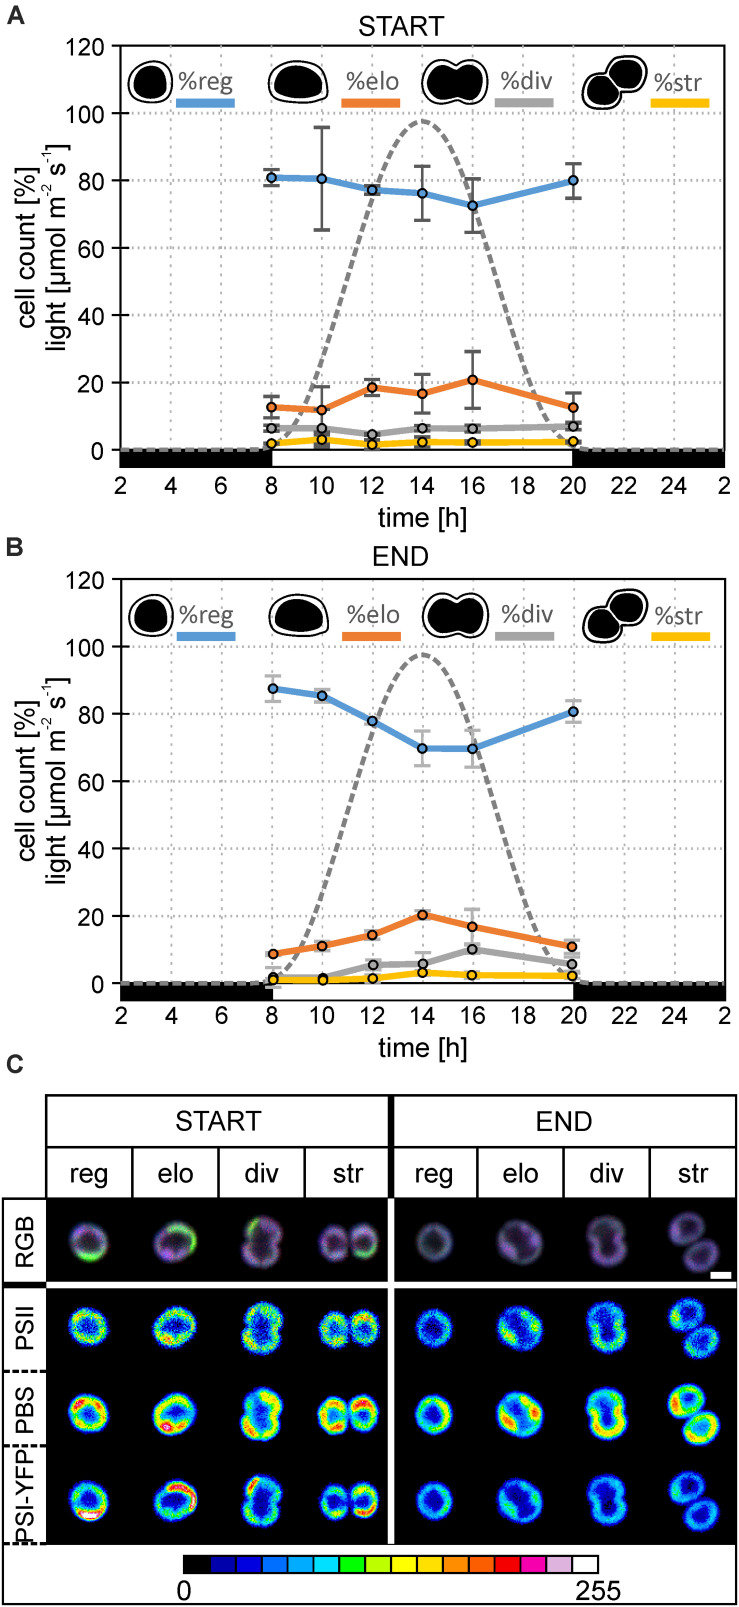
Changes in the diel distribution of cell types and microdomain localization in the particular type of Synechocystis PSI-YFP cells. The original starting culture (“START”; cells acclimated to continuous light; days 2 and 3 in the bioreactor) was slowly acclimated in the bioreactor to the sinusoidal light- night cycle (“END”, days 13 and 14 in bioreactor). The light intensity profile is shown as a gray dotted line. The figure describes diel changes in the cell counts and microdomains organization in the four cell types based on their shapes, namely: “reg”—regular cells; “elo”—elongated cells; “div”—dividing cells; “str”—string cells after division. Total number of cells analyzed per day was between n = 709 and 1565. (A) Diel cycle of relative cell counts of four typical cells—regular, elongated, dividing, string—the start of bioreactor experiment (i.e., Synechocystis PSI–YFP acclimated to continuous light). Intensity of sinusoidal light during the day is marked by a gray dotted line. Data represent averages and SD from 2 days of experiment (days 2 and 3). (B) Diel cycle of relative cell counts of four typical cells—regular, elongated, dividing, string—end of bioreactor experiment (i.e., Synechocystis PSI–YFP acclimated to light-dark cycle). Intensity of sinusoidal light during the day is marked by a gray dotted line. Data represent averages and SD from 2 days of the experiment (days 13 and 14). (C) A typical microdomain organization of four typical cells—regular, elongated, dividing, string. The figure compares the start (days 2 and 3) and at the end (days 13 and 14) of the bioreactor experiment. Total number of cells analyzed per day was between n = 709 and 1565. The first row shows three channels pictures (RGB, 24-bit) with co-localization of PSII, PBS, and PSI-YFP. Colors reflect PSI/PSII/PBS co-localization, the most dominant colors were magenta (dominant PBS and PSII), green (dominant PSI), white (balanced PSI, PSII, and PBS), and blue (dominant PBS). Second, third, and fourth rows depict intensity of single-channel fluorescence of PSII, PBS, and PSI-YFP, respectively. Colors reflect intensity of fluorescence signal per channel (heatmap images) in the 8-bit scale 0–255 (see the color scale bar).